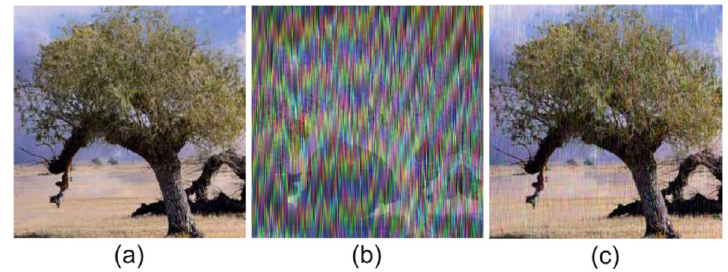
Fig. 8 a Picture waiting to be sent, b picture encrypted, c picture after